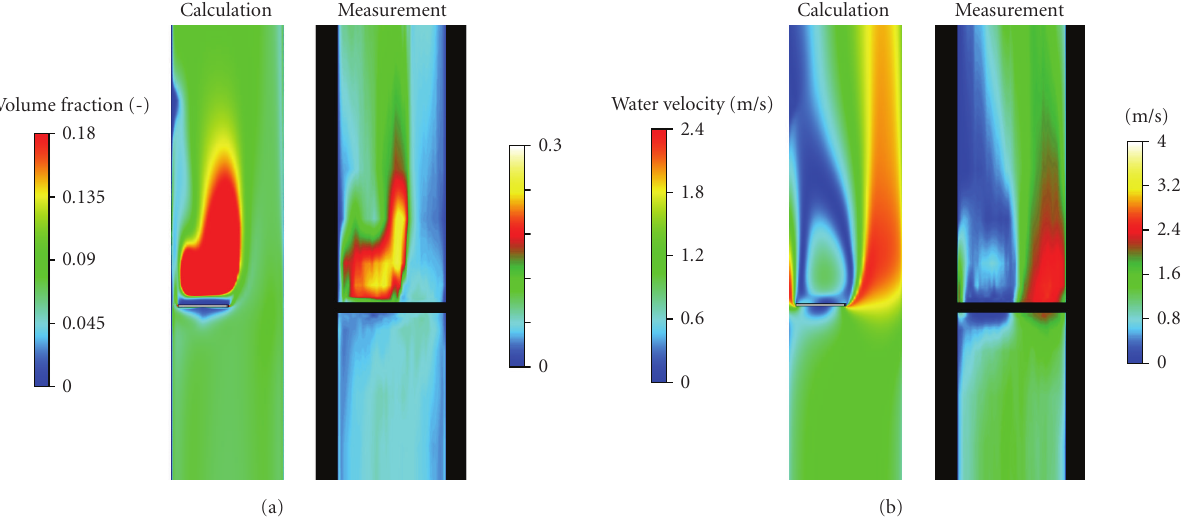
Figure 4: Comparison of time averaged values calculated by CFX (left) and measured (right) up- and downstream of the obstacle in the